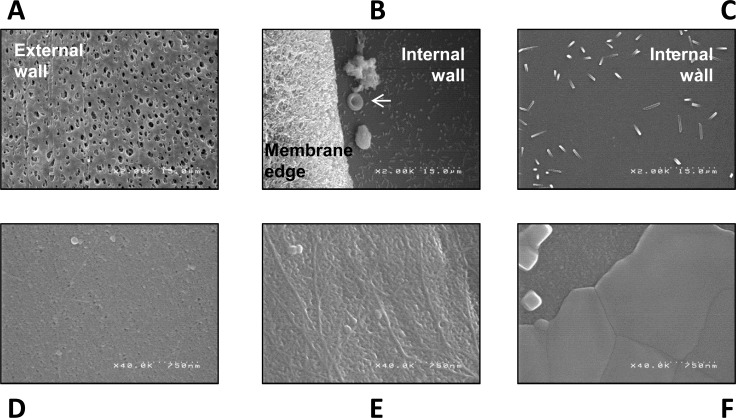
Electron microscopy of the membrane AMEMBRIS used in the study.An example of one dialyser used in hemodialysis is given in the upper panels (A, B and C; x2,000 magnification) and of one dialyser used in hemodiafiltration in the lower panels (D, E and F; x40,000 magnification). (A) The external wall displays visible pores, significantly larger than the pores of the internal wall (B and C), which are not visible at x2,000 magnification. (B) The arrow points at one erythrocyte located between 2 cumulated material and crystals from the rinsing fluid (saline and sodium dodecyl sulphate). (C) Sparse crystals are laying on the internal wall. Three different zones of the internal wall of the dialyser are displayed in the lower panels at x40,000 magnification, one with practically all the pores visible and accessible (D), one with some pores covered by a proteinaceous material (E) and one where all the pores are covered by a uniform material attached to the membrane (F).